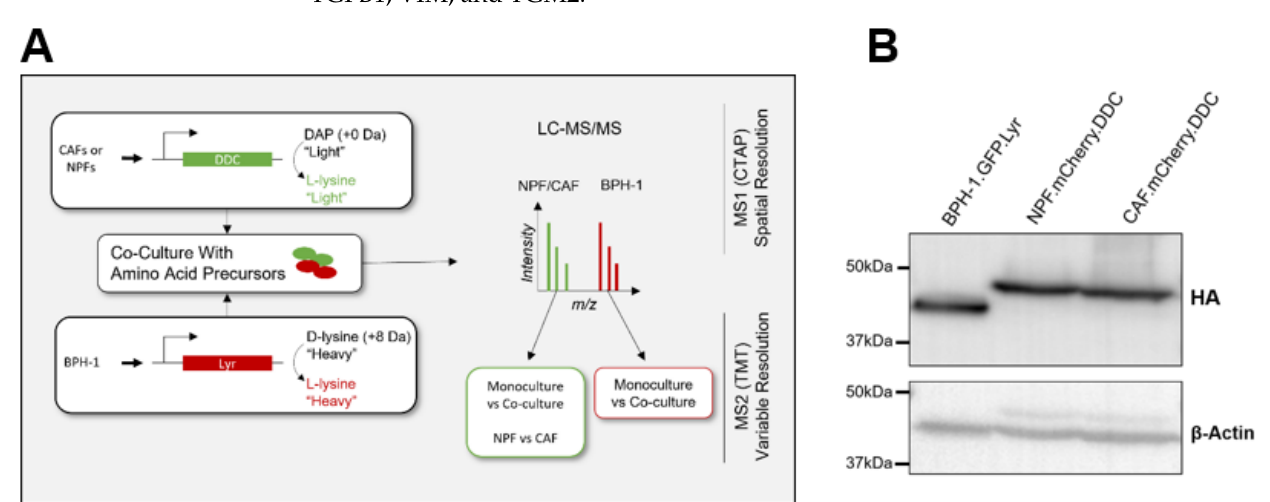
Figure 1. Application of CTAP to benign prostate epithelial cell–prostate fibroblast intercellular communication. ( A ) CTAP provides spatial resolution, identifying which cell type the MS-detected peptides are derived from. Patient-derived fibroblasts (NPFs and CAFs) and BPH-1 cells were modified to express DDCM.tub-KDEL (DDC) and LyrM37-KDEL (Lyr), respectively. Cells were cultured with differentially isotopically-labelled amino acid precursors to allow identification of the cell-type of origin during LC-MS/MS proteomic analysis. Discrimination between additional variables was achieved by differential isobaric tandem mass tag (TMT) labelling of peptides. Adapted from Tape et al., 2014 [10]. ( B ) Western blot validation that the BPH-1 and NPF/CAFs express HA-tagged Lyr and DDC, respectively. Table 1. BPH-1 Protein fold-change in co-culture experiments. Top differentially regulated proteins in BPH-1 cells in CAF co-culture compared to monoculture (>twofold change in either direction and p < 0.05) compared to BPH1 in NPF co-culture vs. monoculture. Data are displayed as mean fold-change of raw protein intensity from mass spectrometry measurement ± SD from three biologi- cal replicates and p -value calculated from Student’s t -test comparing monoculture and co-culture. * p < 0.05, ** p < 0.01, *** p < 0.001. BPH-1 Protein